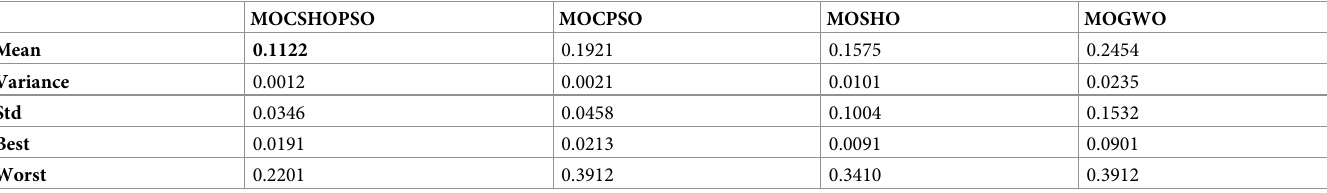
Table 6. Comparative analysis of different algorithms based on the error